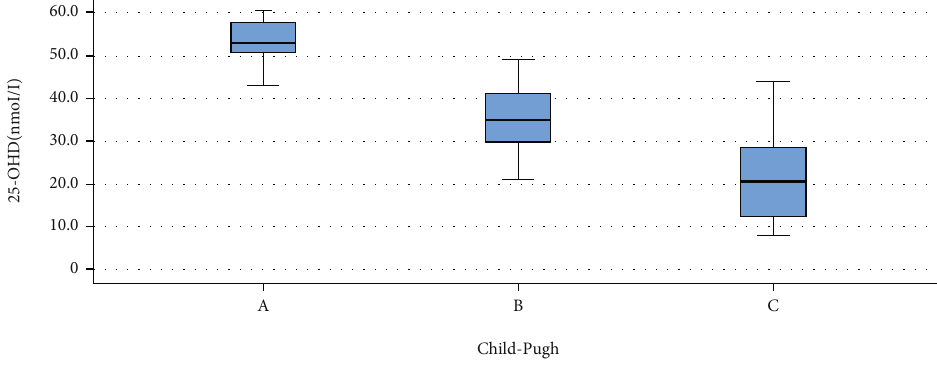
Figure 4: Comparison of 25-OHD in di ff erent CTP categories (A fifi , Hussein, and Rizk, 2020). Table 8: Correlation between 25-OHD level and MELD score.